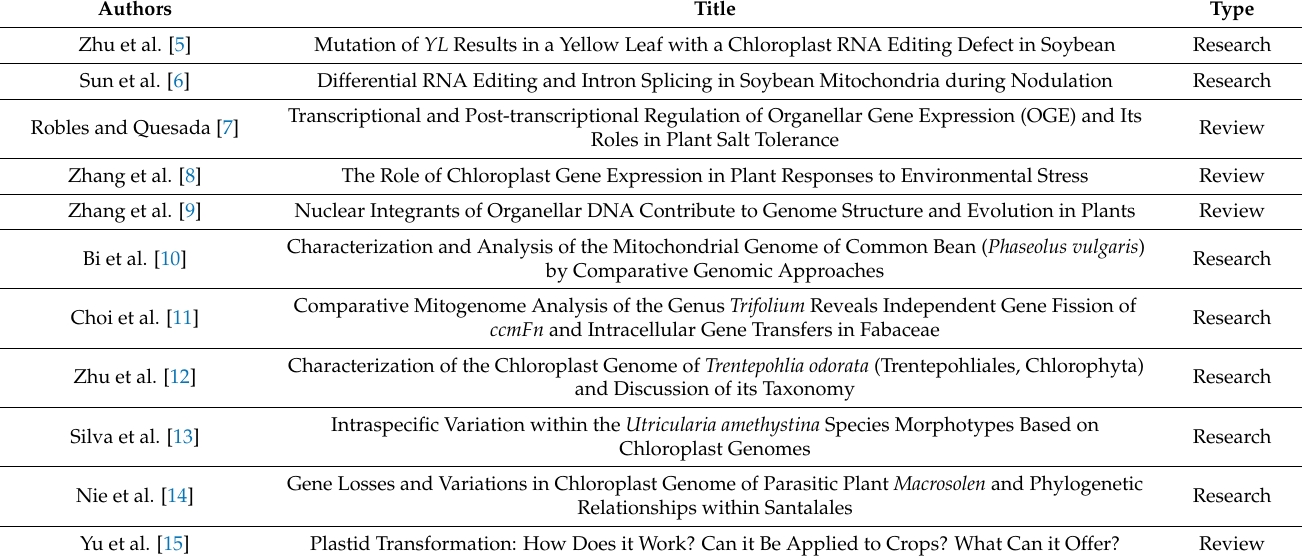
Table 1. Contributors to the Special Issue “Organelle Genetics in